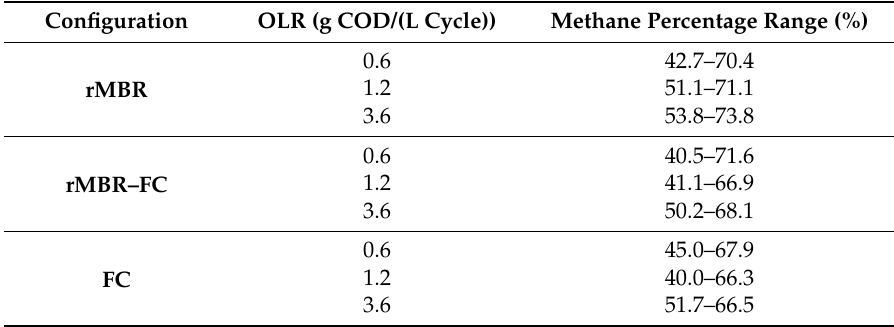
Figure 4. Biogas composition profile for OLRs: ( a ) 0.6; ( b ) 1.2; ( c ) 3.6 g VS/(L cycle). Table 3. Range of methane percentage.